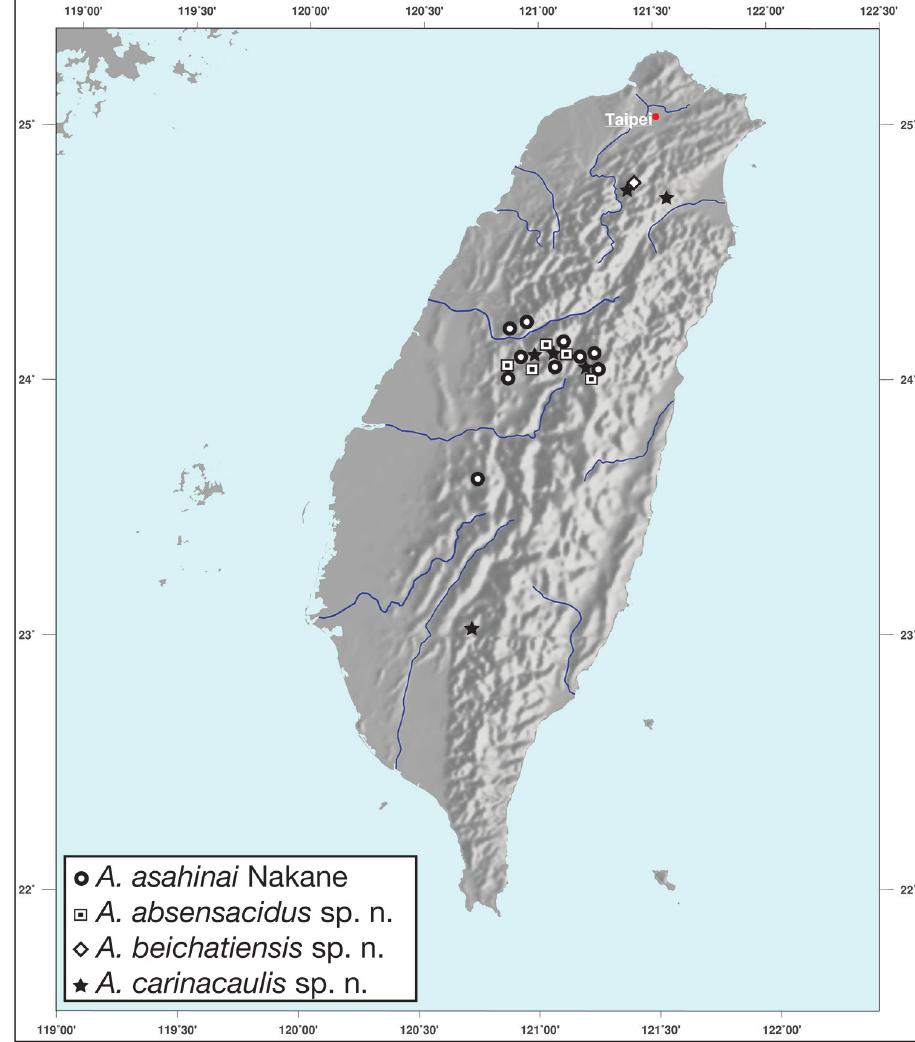
Figure 12. Map showing known localities for species of the genus Amphimenes Bates, in